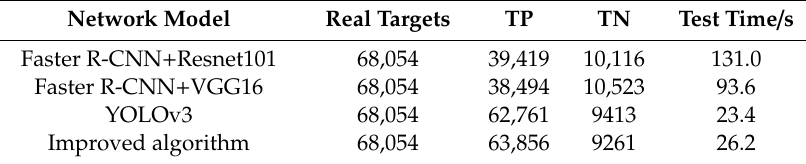
Table 2. Detection results of four models on the MyShip dataset.